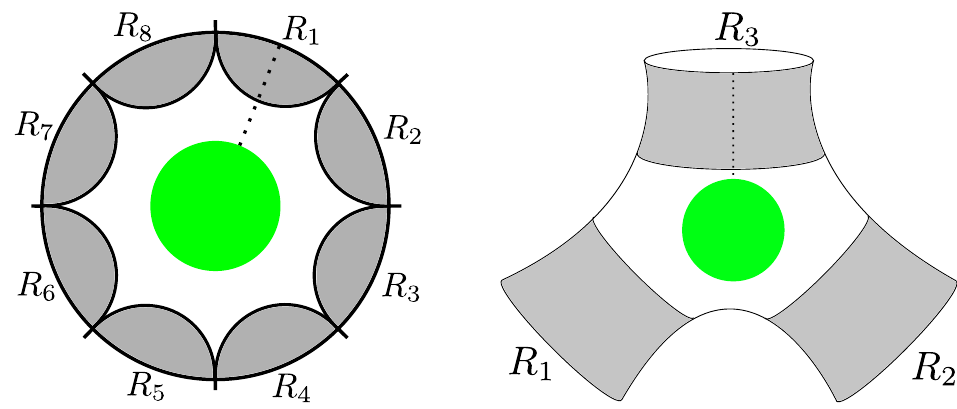
Figure 3 . Two situations where a bulk global symmetry would lead to a contradiction in AdS/CFT (figures from [7]). The green circle represents a putative bulk operator which is charged under the global symmetry, and the dotted line represents its (neutral) gravitational dressing. The contradic- tion is that in the boundary CFT a global symmetry operator U( g ) must be a product of operators whose support is each at most one of the R , and each of those operators can therefore only act non- i trivially on bulk operators in the entanglement wedge of that R . Thus none of the operators, and i therefore also their product, can act nontrivially on the green charged operator: it must be